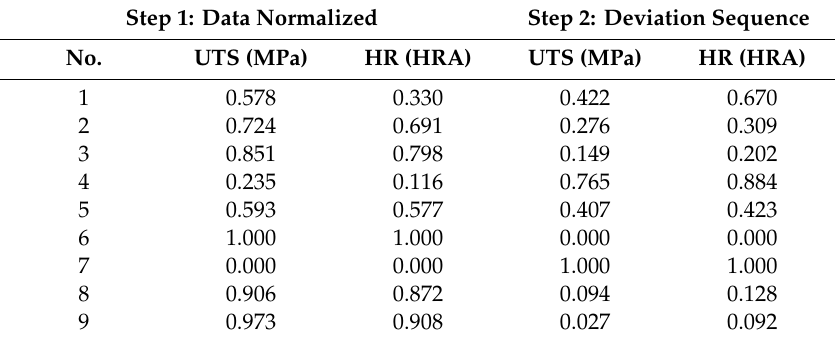
Table 11. Data normalization and deviation